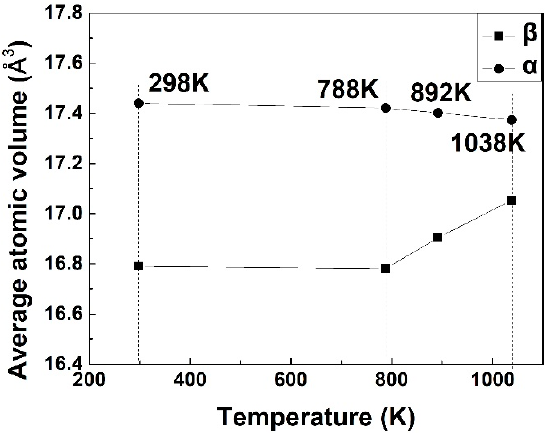
Figure 7. The average atomic volume of α and β in the bimodal Ti-55531 alloys which were heated to the target temperatures at 1 K/min followed by water quench.